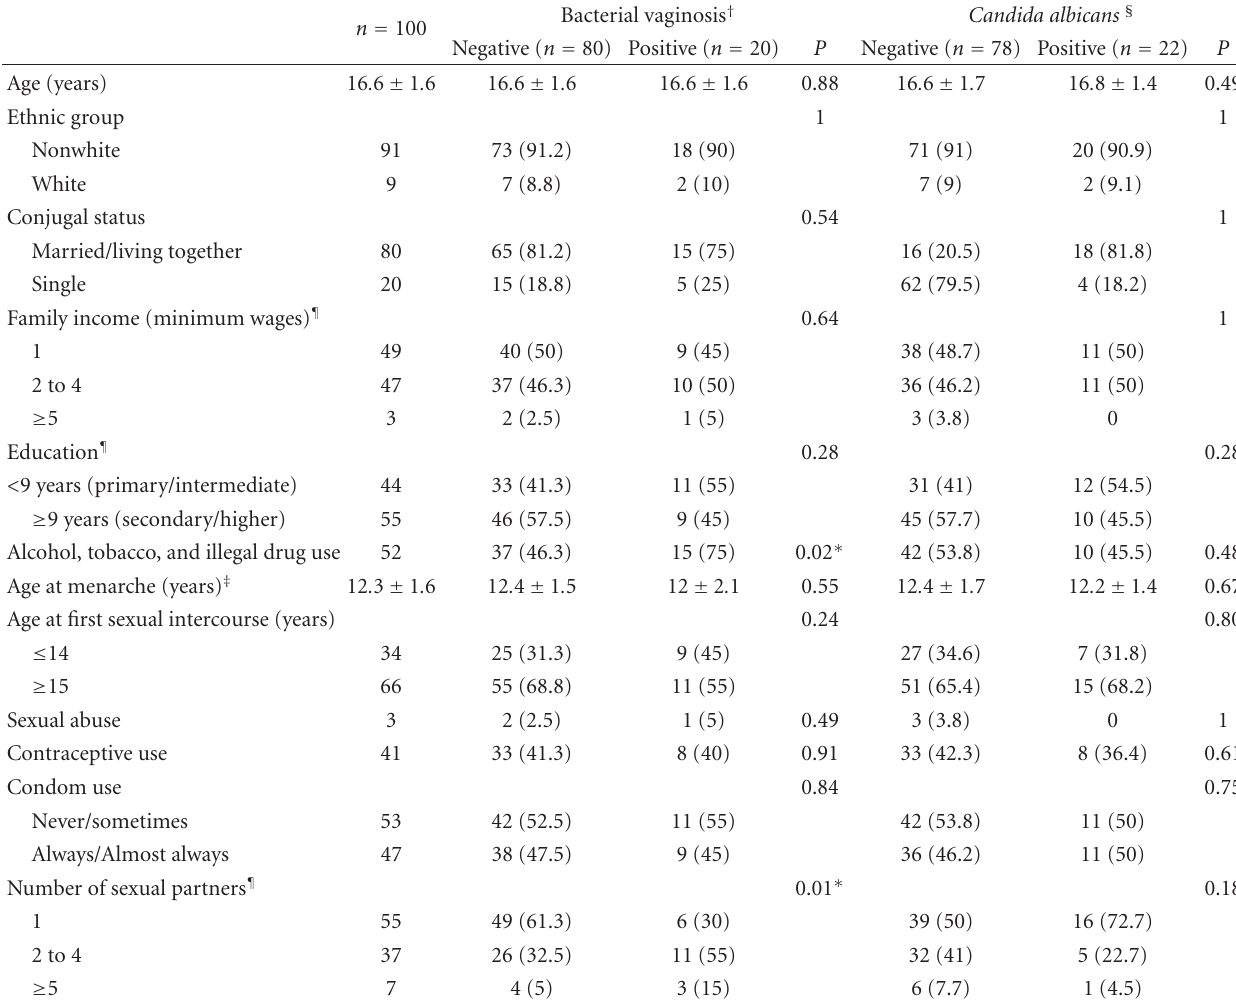
Table 1: Sociodemographic and behavioral characteristics of the study population, stratified by the presence or absence of bacterial vaginosis or genital Candida albicans